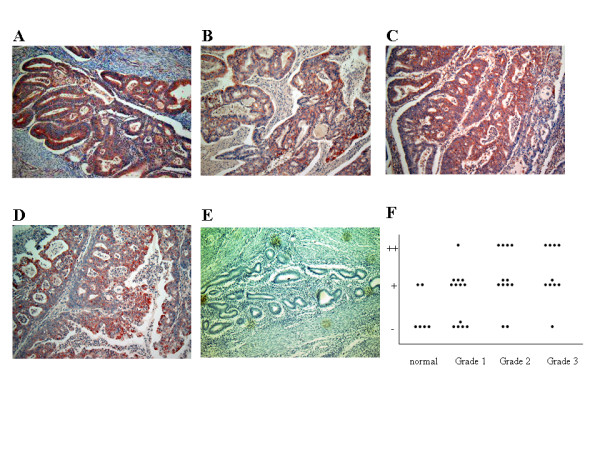
Immunochemical localizations of P-LAP/IRAP, GLUT4, IR, and IRS-1 in human endometrioid adenocarcinoma tissues (Magnification, × 200). A: P-LAP/IRAP in a grade 2 endometrioid adenocarcinoma. B: GLUT4. C: IR. D: IRS 1. Immunoreactivites of P-LAP/IRAP, GLUT4, IR, and IRS-1 were positive in carcinoma cells. E: Negative control (no primary antibody) in normal endometrial tissue.